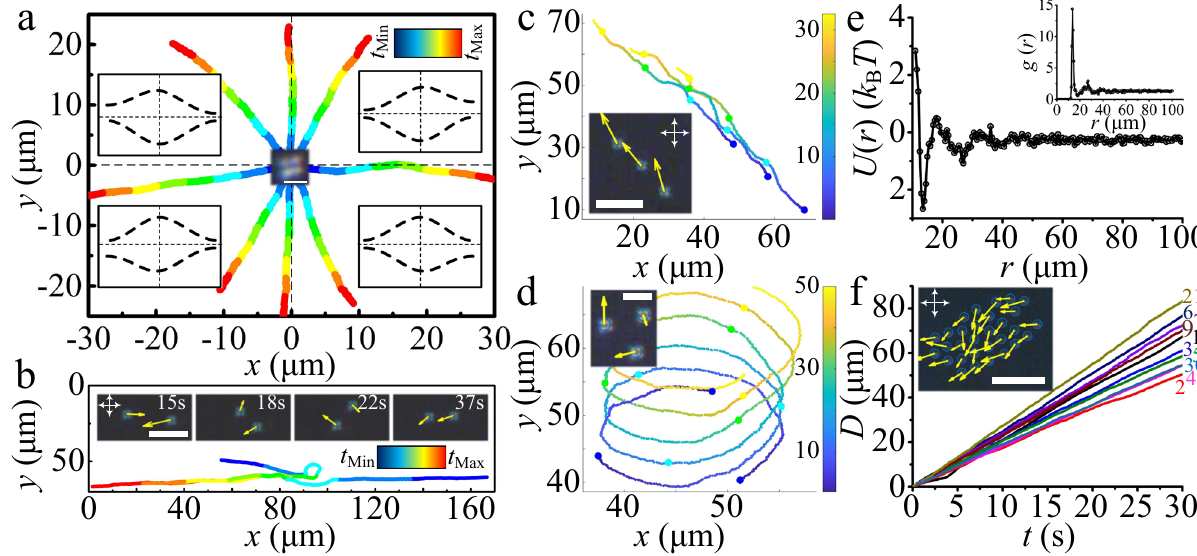
Fig. 2 Dynamics of directrons. a Trajectories of eight individual directrons at U = 15.4 V, f = 100 Hz, colored with time corresponding to the color bar ( t Min = 0 s, t Max = 10 s). The insets in four quadrants show the schematic symmetry-breaking middle-layer director structures of the directrons. The inset in the middle shows the polarizing micrograph of a directron. Scale bar 5 μ m. b Trajectories of two directrons at U = 15.4 V, f = 100 Hz colliding with each other, colored with time corresponding to the color bar ( t Min = 0 s, t Max = 67 s). The insets show the time sequences of micrographs of the two directrons with yellow arrows representing the velocities, scale bar 20 μ m. c , d Trajectories of three directrons at U = 15.4 V, f = 100 Hz, colored with time corresponding to the color bars (unit (s)). The directrons demonstrate linear motion ( c ) and circular motion ( d ). The insets show the micrographs of the three directrons with their velocities represented as yellow arrows. Scale bars 20 μ m in c and 10 μ m in d . e Pair interaction potential function (extracted from the radial distribution function g ( r ) shown in the inset) of the directrons at U = 15.2 V, f = 100 Hz. f Dependence of displacements ( D ) of groups of different number of directrons on time ( t ). The inset shows the micrograph of the group composed of 30 directrons with their velocities representing as yellow arrows. Scale bar 50 μ m. The white crossed arrows in the micrographs indicate the polarizers.